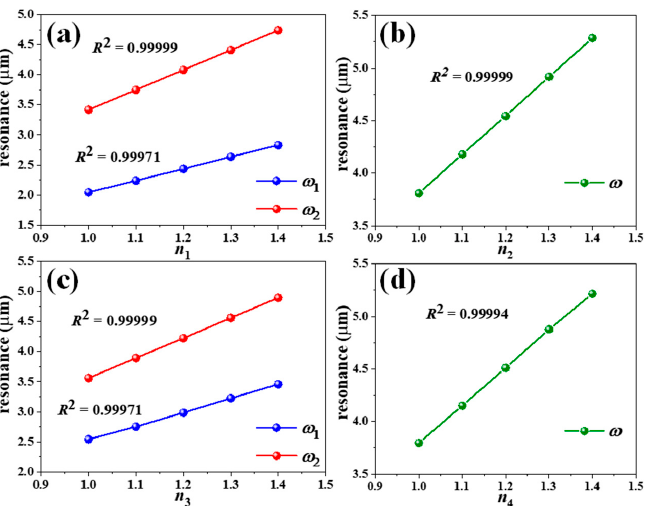
Figure 6. The relationships of resonances and n values of ( a ) SDM-1, ( b ) SDM-2, ( c ) SDM-3, and ( d ) SDM-4, respectively.